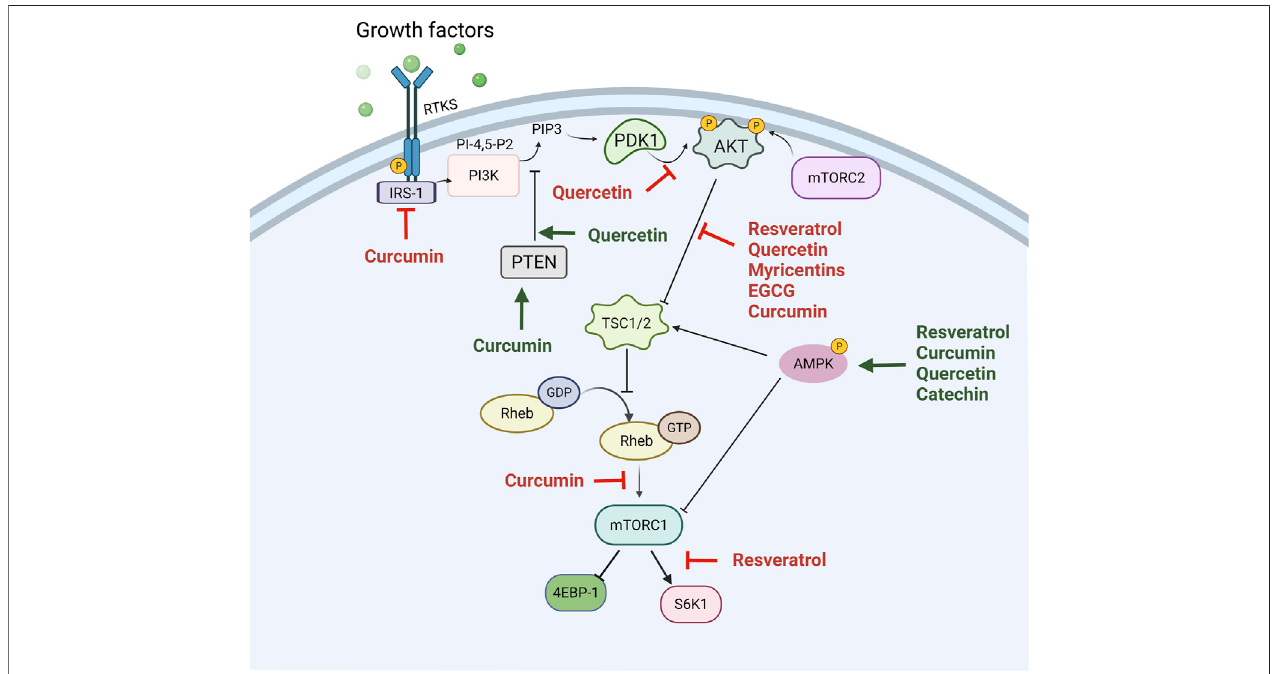
FIGURE 4 | The inhibition of the PI3K/Akt/mTOR pathway by polyphenols in cancer. The phosphoinositide 3-kinase-AKT-mammalian target of rapamycin (PI3K/ Akt/mTOR)pathwayishyperactivatedinseveralcancersandisimportantintermsoftumor cellgrowthandsurvival.ActivationofRTK,suchasinsulin-likegrowthfactor- 1 receptor (IGFR), by growth factors such as insulin, can initiate activation of intracellular pathways. Akt is phosphorylated downstream of PI3K with various effects, includingtheactivationofmTOR.mTORphosphorylatesp70S6Kand4E-bindingprotein1(4EBP-1),whichthenleadstoanincreasedtranslationofmRNAandcell growth. Polyphenols act by inhibiting this pathway by means of decreasing the phosphorylation of several protein kinases that are part of this signaling pathway. The green arrows indicate the activation of the pathway, while the red arrows indicate the inhibition of the pathway using different